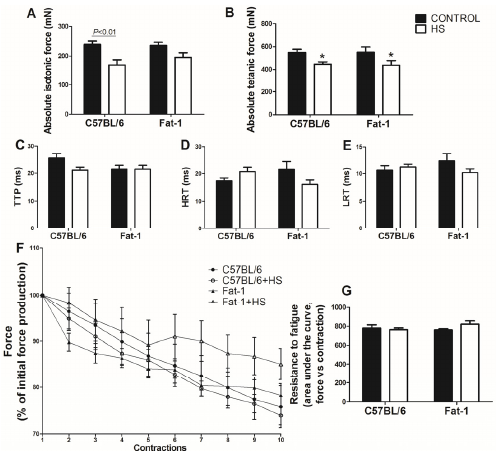
Figure 1. Muscle strength, contractile properties and muscle fatigue of the four groups studied (C57BL/6, C57BL/6 + HS, Fat-1, Fat-1 + HS) in the soleus muscle. Muscle strength: ( A ) Absolute isotonic force. ( B ) Absolute tetanic force. Contractile properties: ( C ) TTP; ( D ) HRT; ( E ) LRT. Muscle fatigue: ( F ) and ( G ) Resistance to fatigue (force vs contraction). Values are presented as mean ± SEM, n = 5–8 animals. The results were compared using two-way ANOVA and Bonferroni post-hoc test. In ( A ), p < 0.01 indicates significant difference using the Bonferroni post-hoc test. In ( B ), * p < 0.01 for C57BL/6 and Fat-1 groups vs. C57BL/6 + HS and Fat-1 + HS groups (main effect of HS), using